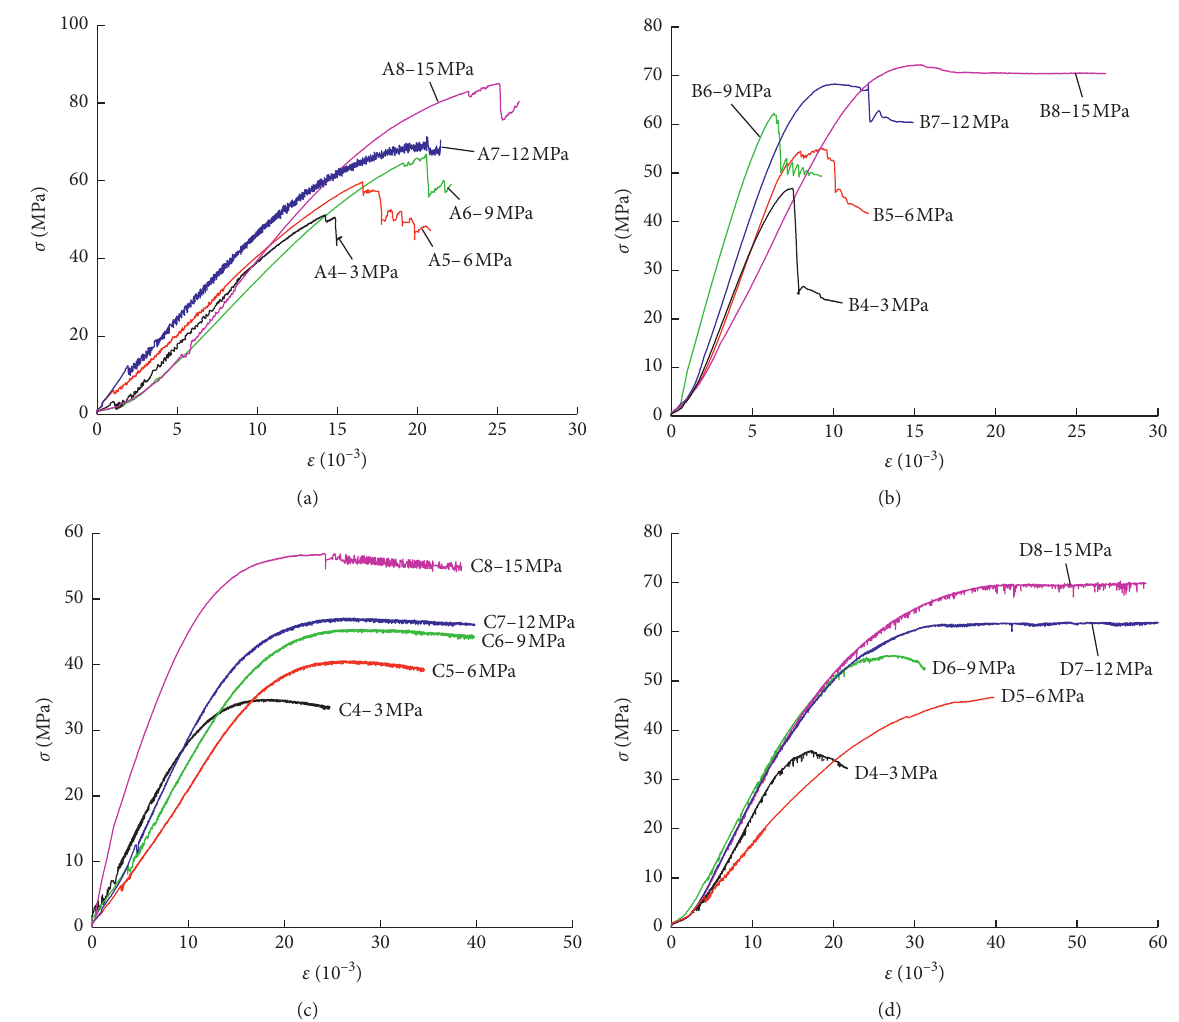
Figure 7: Complete stress-strain curve of each group of samples during triaxial compression test. (a) Natural. (b) Dehydration at 45 ° C. (c) Water saturation. (d) High-temperature dehydration at 220 ° C. Table 2: Triaxial compression test results of high-strength gypsum powder remolded samples. No. σ 3 (MPa) σ 1 (MPa)